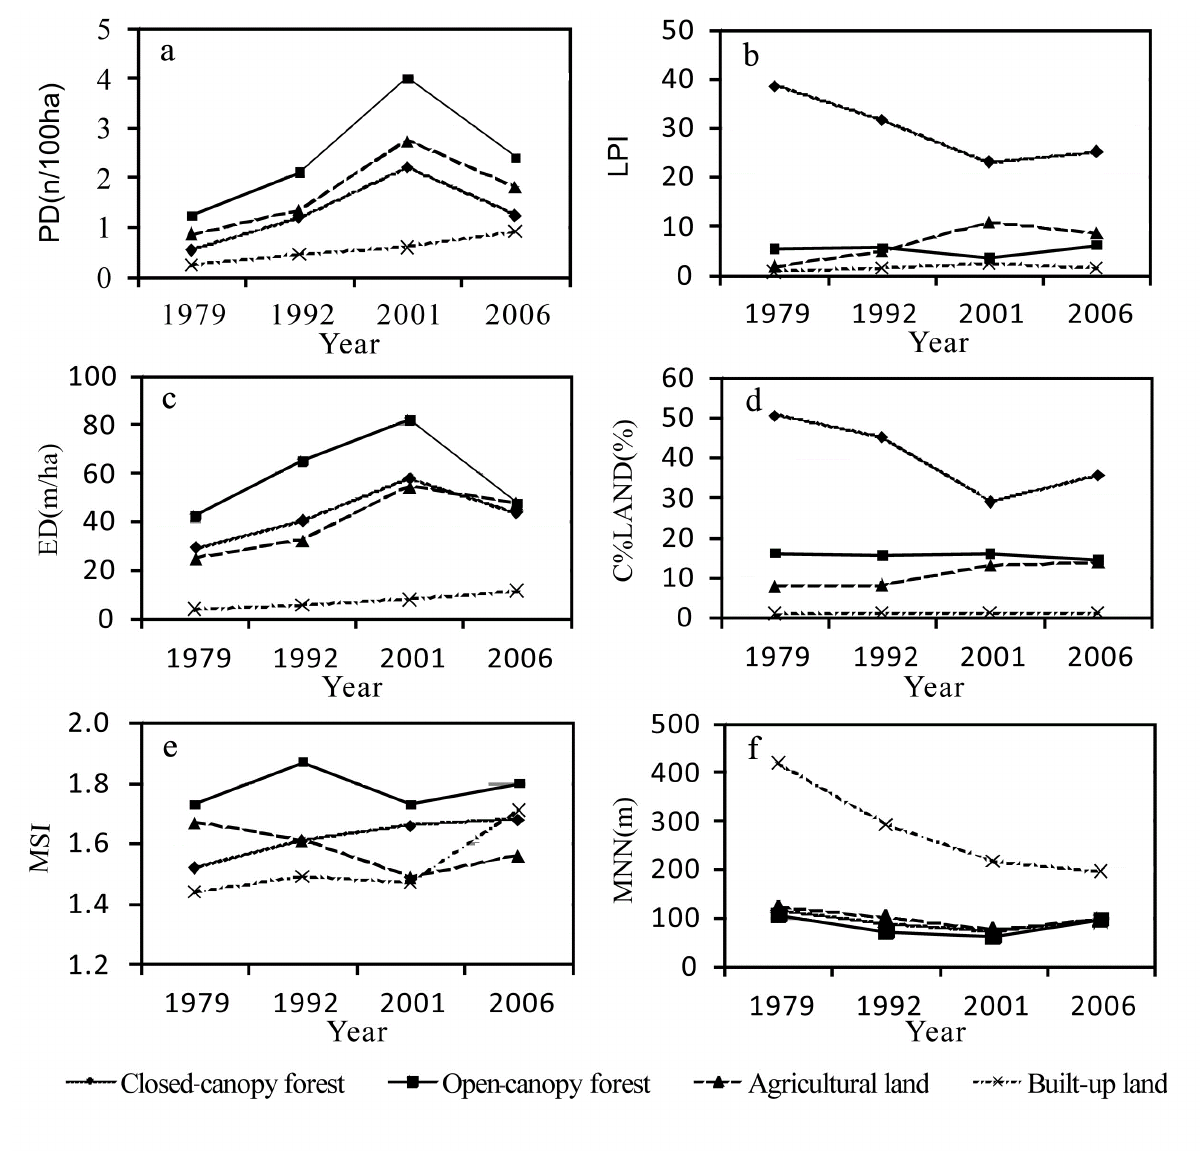
Figure 6 Temporal dynamics for selected landscape metrics within Suan